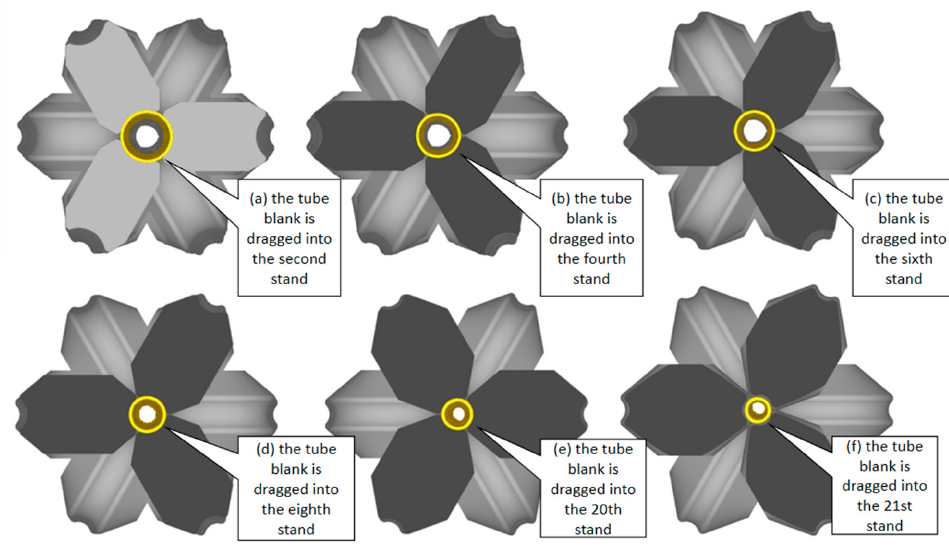
Figure 10. Partial cross-sectional view.